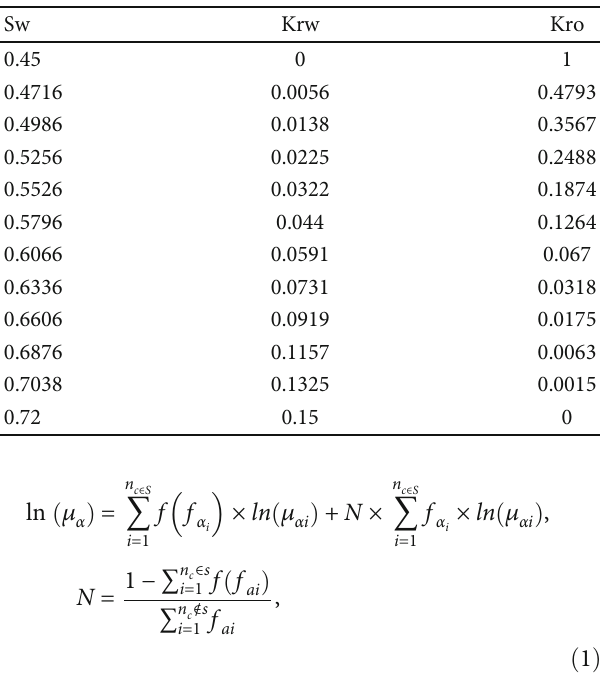
Table 5: Rock relative permeability data.